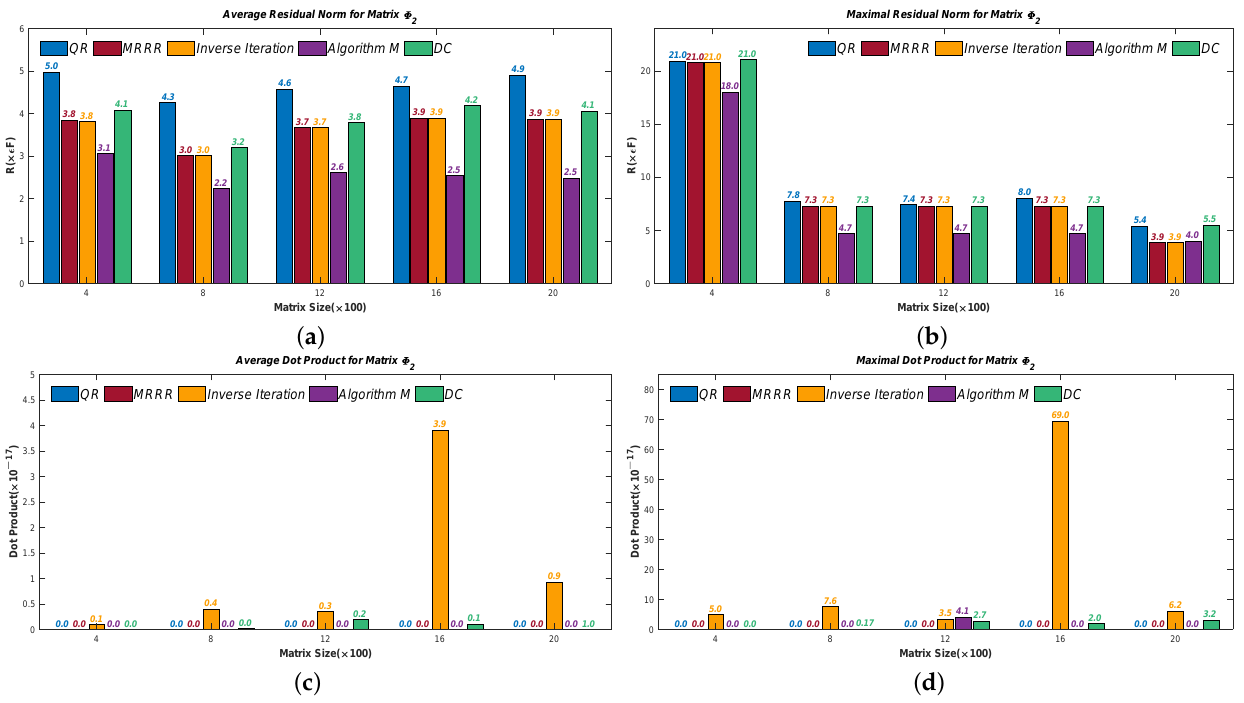
Figure 6. The accuracy results of Matrix Φ 2 : ( a ) the average residual norm; ( b ) the maximal residual norm; ( c ) the average dot product; ( d ) the maximal dot product.